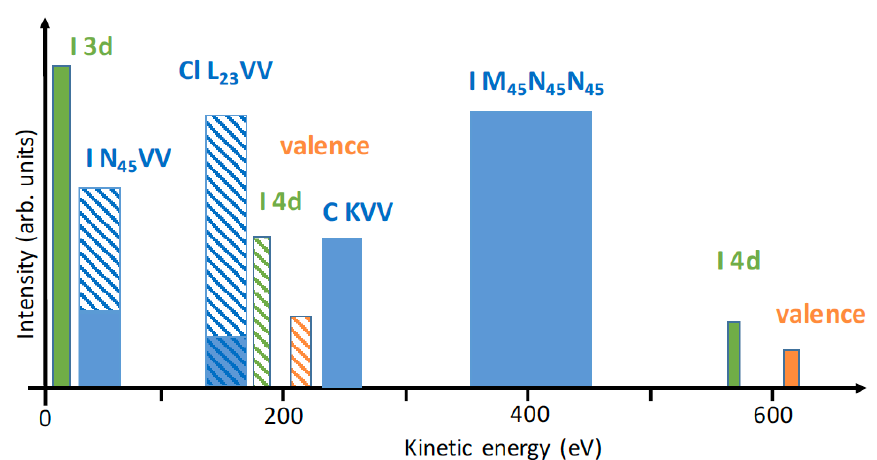
Figure 4. Schematic representation of the electron spectrum recorded on a IC n H 2n Cl molecule upon ionization with two pulses at photon energies at 250 eV and 630 eV, the corresponding contributions are marked by striped and full rectangles, respectively. The intensity ratios between the different contributions are not to